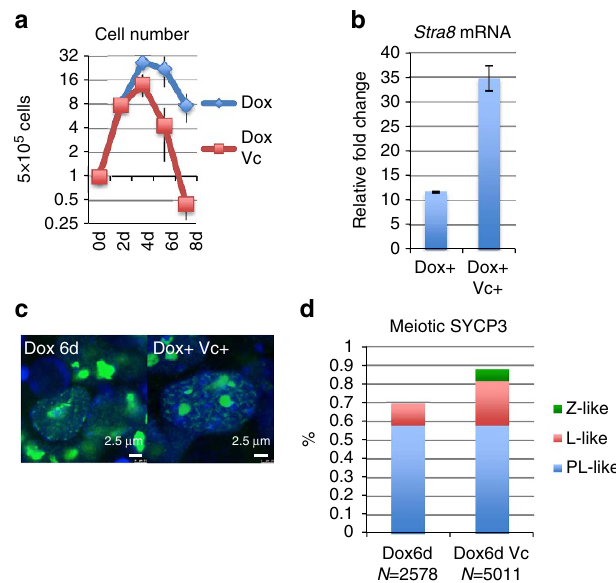
Figure 3 | Vitamin C enhances meiosis-related changes in Max expression-ablated ESCs. ( a ) Total number of viable Dox-treated Max -null ESCs cultured in the presence or absence of vitamin C at the indicated days after Dox addition. The number of cells at day 0 (0d) was arbitrarily set to one ( n ¼ 3, means ± s.d.). ( b ) Expression levels of the Stra8 gene in Dox- treated Max -null ESCs cultured in the presence or absence of vitamin C for 4 days (4d). The expression level of the Stra8 gene in untreated control Max -null ESCs was arbitrarily set to one ( n ¼ 3, means ± s.d.). ( c ) Representative meiosis-like SYCP3-staining patterns in Dox-treated Max -null ESCs cultured in the absence or presence of vitamin C for 6 days (6d). ( d ) Frequency of meiosis-like SYCP3-staining patterns in Max -null ESCs treated only with Dox for 6 days or together with vitamin